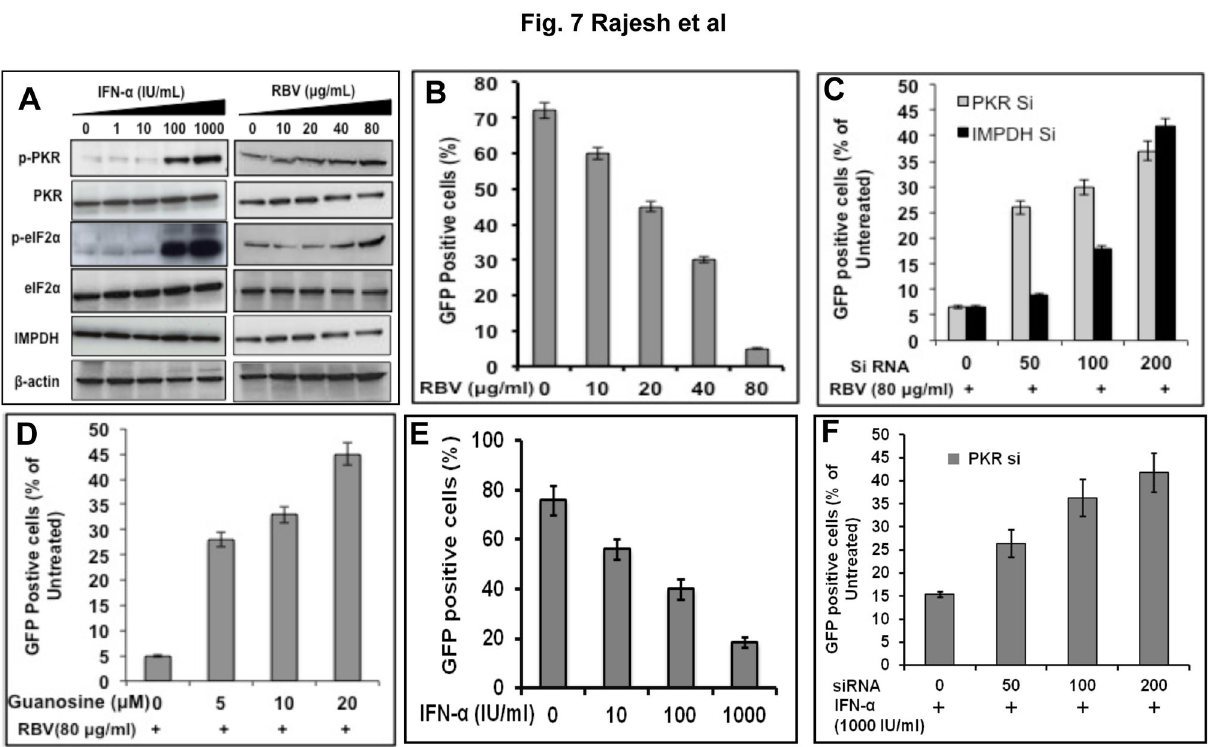
Figure 7. IFN-α and RBV synergy antiviral mechanism involves the activation of PKR, eIF2α and inhibition of cellular IMPDH. ( A ) IFN-α and RBV each induced phosphorylation of PKR and eIF2α. ( B ) Flow cytometric analysis showing RBV show a dose dependent inhibition of HCV IRES-GFP translation. ( C ) Inhibition of IMPDH and PKR levels by siRNA prevented RBV antiviral action against HCV IRES-GFP translation determined by flow cytometric analysis. ( D ) Dose dependent prevention of RBV action due to increasing concentration of guanosine was determined by flow cytometric analysis. ( E ) IFN-α inhibits HCV IRES-GFP translation. ( F ) Inhibition of PKR by siRNA prevented IFN-α mediated inhibition of HCV IRES-GFP translation. doi: